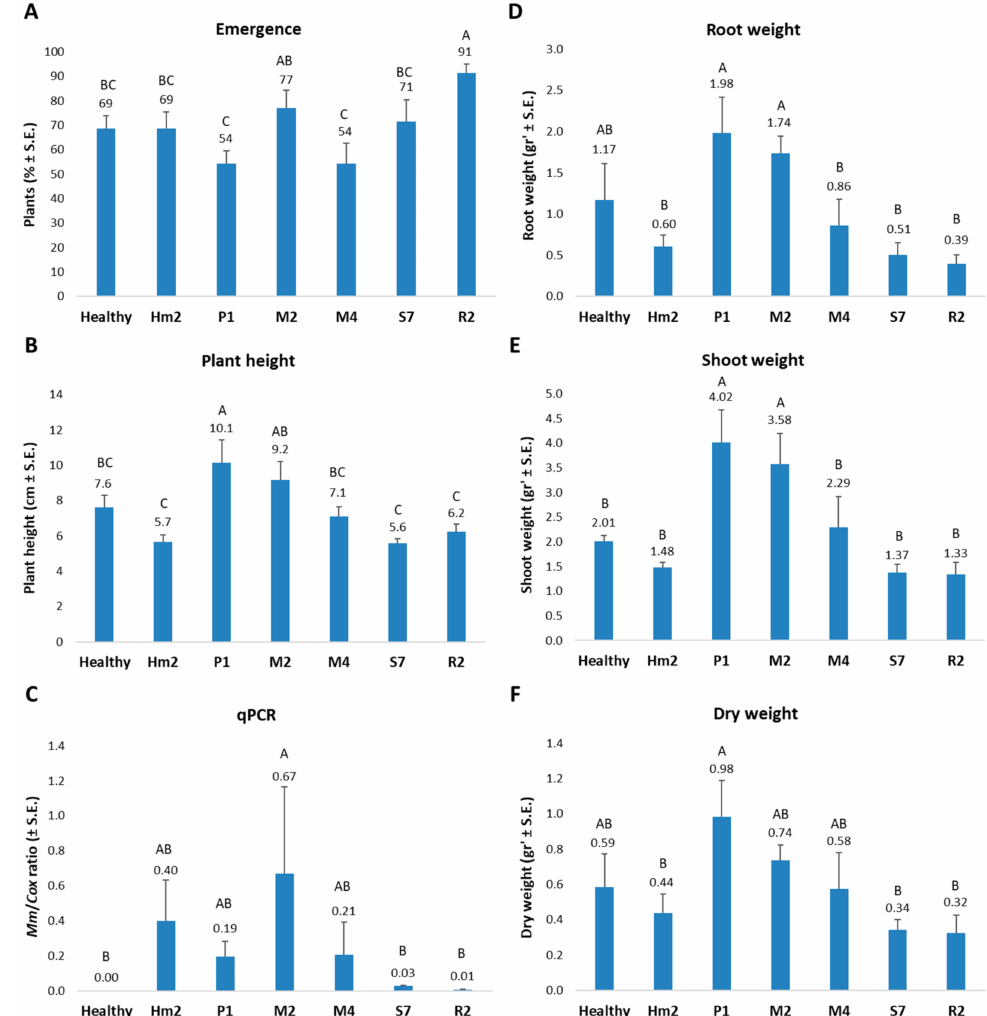
Figure 3. Seedlings pathogenicity assay. Symptoms evaluation was made for the maize late wilt- sensitive Prelude cv. after growing in soil infected with M. maydis in a growth chamber. The seeds were incubated with selected endophytes (Table 3) for two days under moderate humidity conditions prior to sowing. The control seeds underwent similar incubation without endophytes. The emergence percentage of the plants above the ground surface ( A ) was determined eight days after sowing. All other values ( B – F ) were documented after 42 days. The quantitative real-time PCR (qPCR) molecular method’s values ( C ) are M. maydis relative DNA ( Mm ) abundance normalized to the cytochrome C oxidase ( Cox ) DNA. The experiment was performed in five repetitions. Error lines represent a standard error. Statistically significant (one-way ANOVA, p < 0.05) difference between the treatments is indicated by different letters